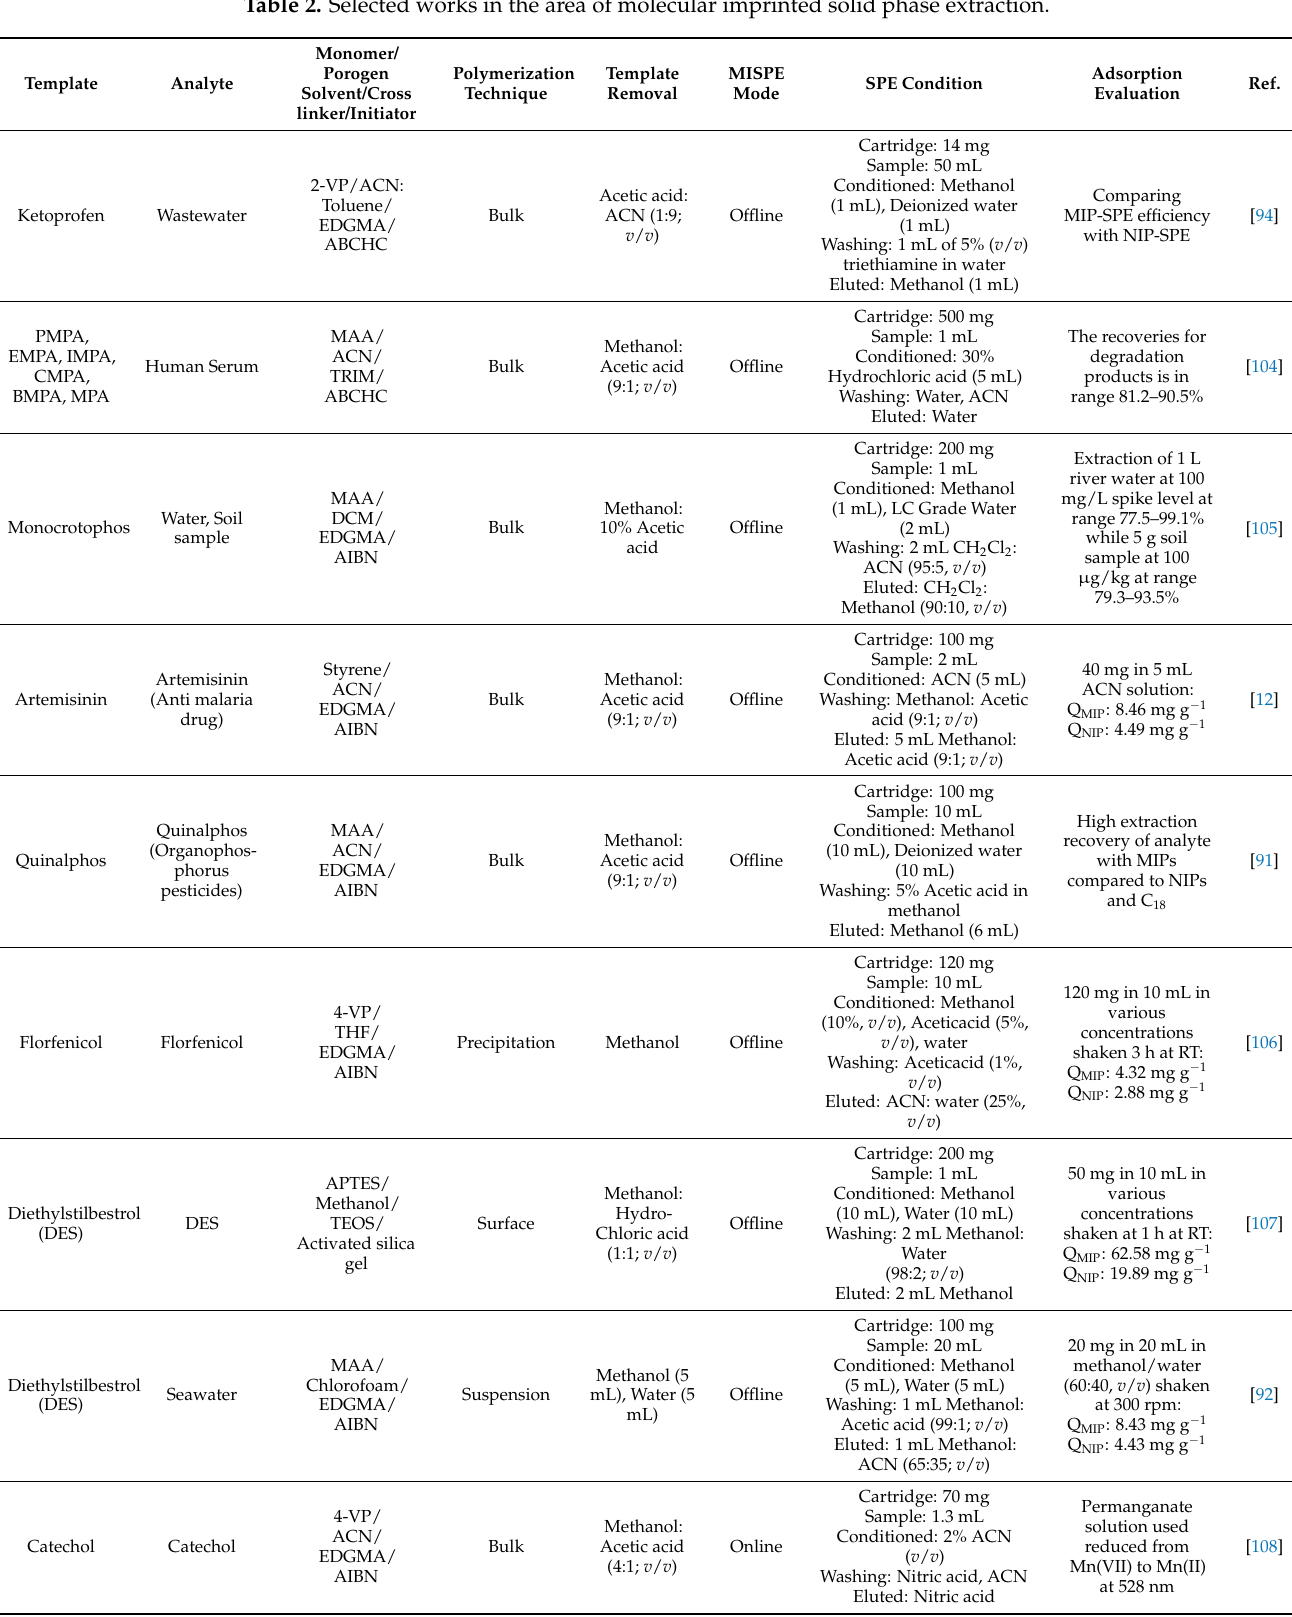
Table 2. Selected works in the area of molecular imprinted solid phase